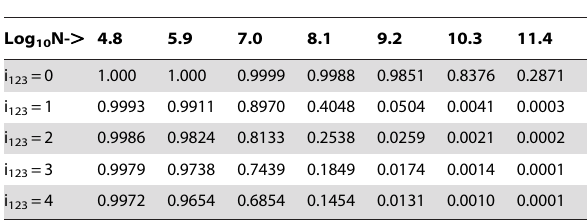
Table 4. Probability of treatment success for a three drug combination treatment with different number of triply-resistant